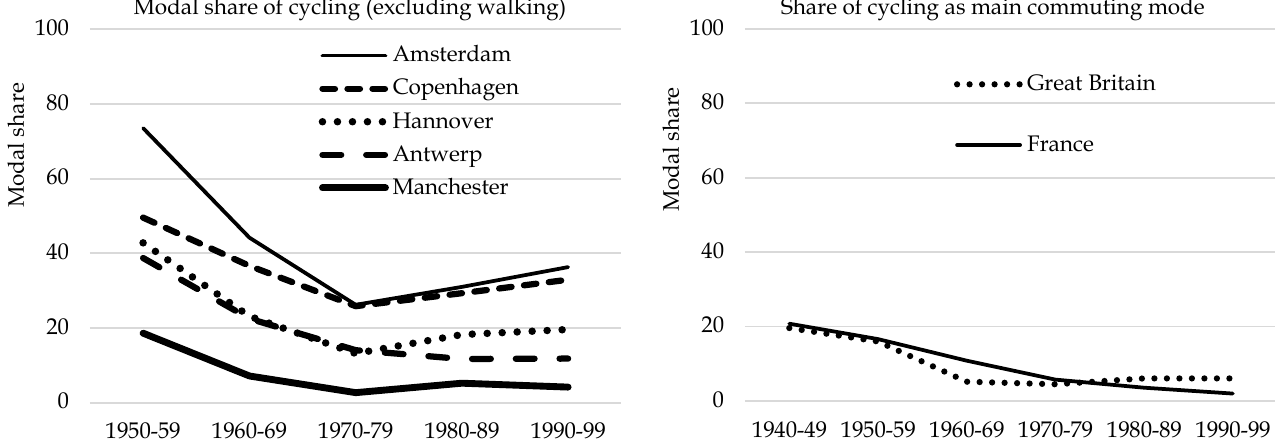
Figure 1. Modal share of cycling: in the left panel excluding walking in large European cities (De la Bruhèze & Veraart, 1999a); in the right panel including walking for commuting in Britain (Pooley & Turnbull, 2000, p. 13) and France (Papon, 2016, p.